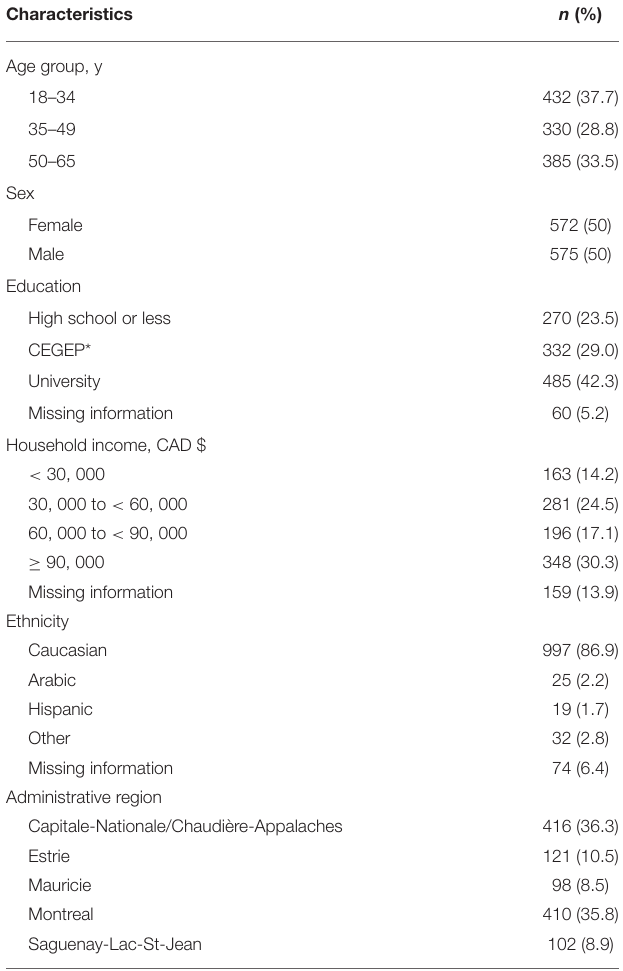
TABLE 3 | Sociodemographic characteristics of the French-speaking adults from Quebec, Canada ( N = 1,147).